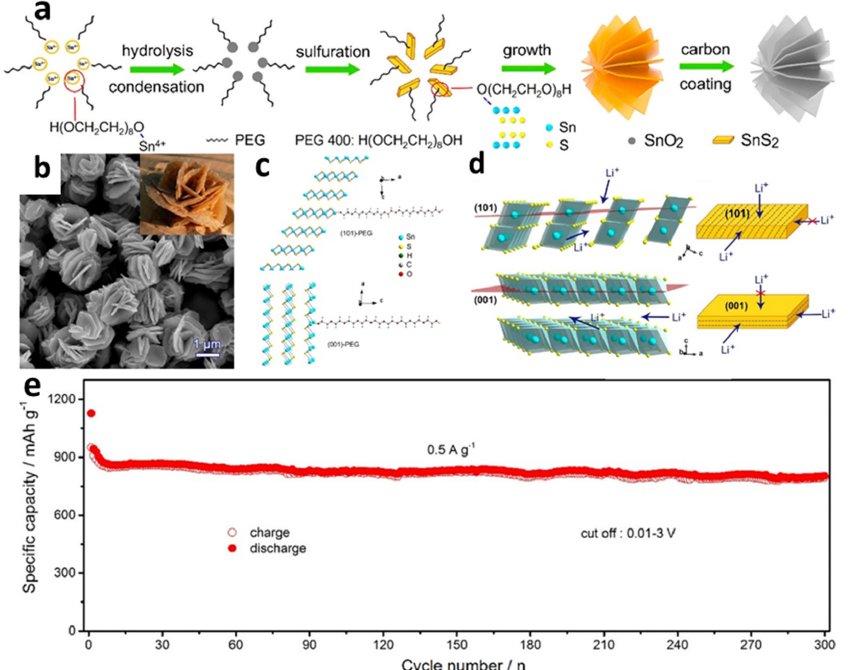
Figure 3. ( a ) Schematic illustration of the formation process; ( b ) SEM images of carbon-encapsulated SnS 2 nanoplates; ( c ) structural models of terminated (101) and (001) surfaces of SnS 2 with adsorbed PEG for first-principles calculation; ( d ) schematic illustration of Li-ion insertion; ( e ) long-term cycling performance of carbon ‐ encapsulated SnS 2 nanoplates with the (101) ‐ oriented plane . Reprinted with permission from Ref. [56]. Copyright 2017 ACS.